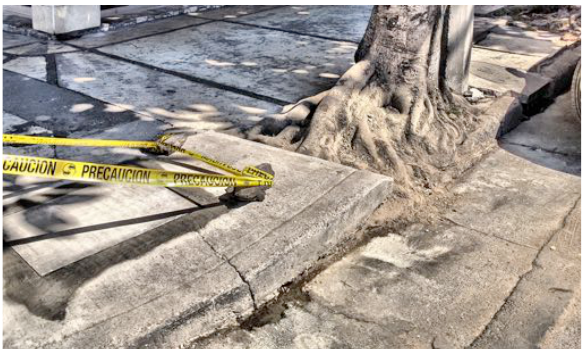
Figure 2. Example of damage and space conflicts caused by proximity of tree roots to urban elements, including pavement cracks, sewer system, electric poles and electrical pit damage. The tree species correspond to Ficus elastica , a common species in Mexico City (CONABIO, Figure 1. Plan view of a tree showing the outline of the canopy or dripline, the root extents and a trench dug through the root zone severing the roots. This view reflects a geometric interaction between the trench and the tree root where both interiors and borders intersect.